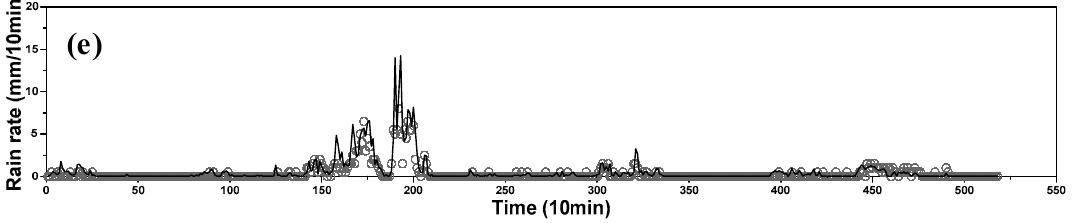
Figure 7. Comparison of radar and rain gauge rain rate at several AWS locations ( a ) #871 (Witse-Oreum, 1750 m); ( b ) #870 (Jindallebat, 1500 m); ( c ) #782 (Seongpanak, 1000 m); ( d ) #751 (Seonheul, 500 m); and ( e ) #189 (Seoqwipo, 250 m).